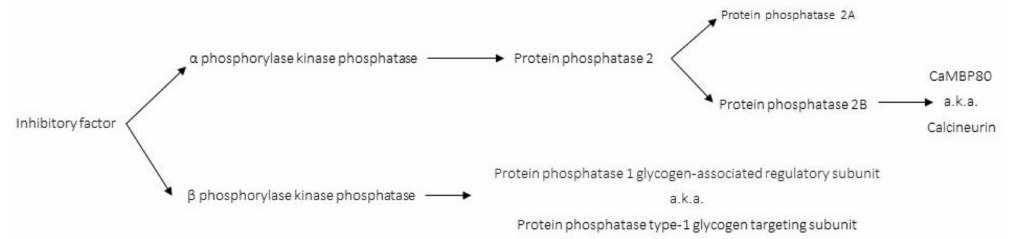
Figure 1. Diagram depicting the development of CaN nomenclature. Also known as